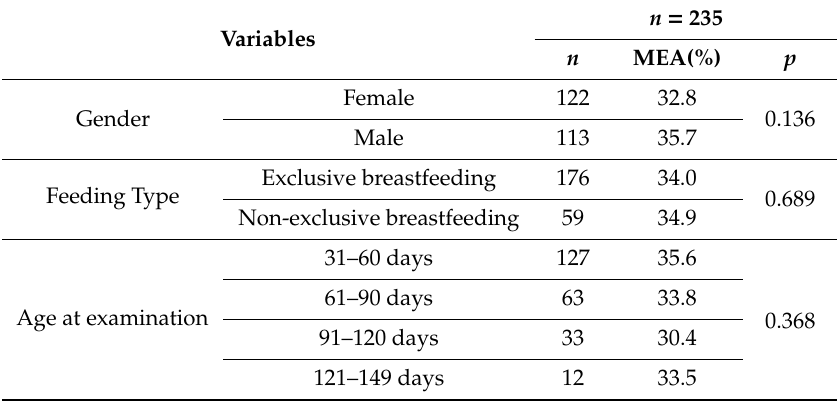
Table 1. Association between the characteristics of infants (gender, feeding type, and age at the examination) and muscular electrical activity (MEA).